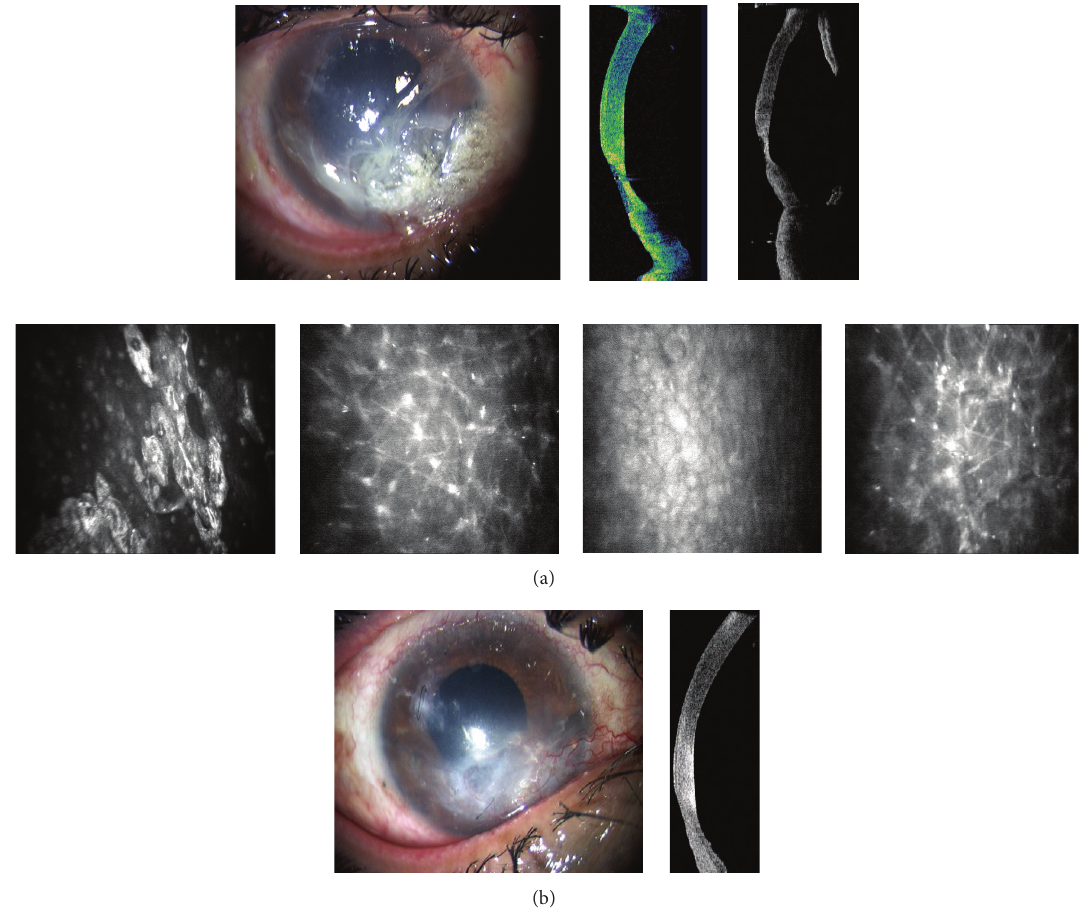
Figure 8: (a) Slit lamp photograph and corresponding AS-OCT and CM images ten days after injury and fungal keratitis ( Candida albicans ) with corneal thinning. Primary repair with sutures, tissue adhesive, and bandage contact lens. (b) Slit lamp photograph and corresponding AS-OCT and CM images of fungal keratitis after five weeks of treatment. Note improving corneal thickness and vascularized